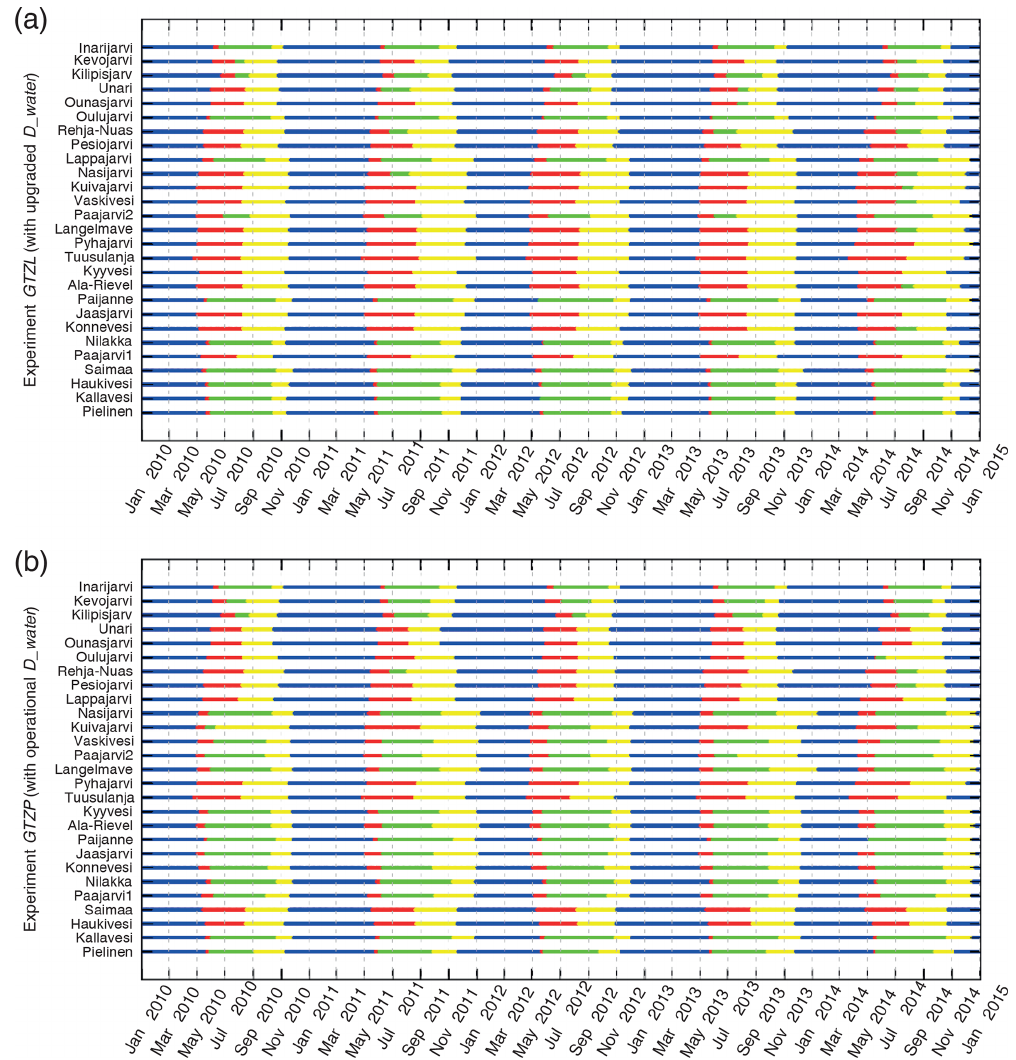
Figure 13. Uninterrupted lake seasons for 2010–2014 for 27 verification sites based on operational (b) and upgraded (a) D water ; blue – winter, red – spring mixing, green – stratified summer, yellow – autumn mixing